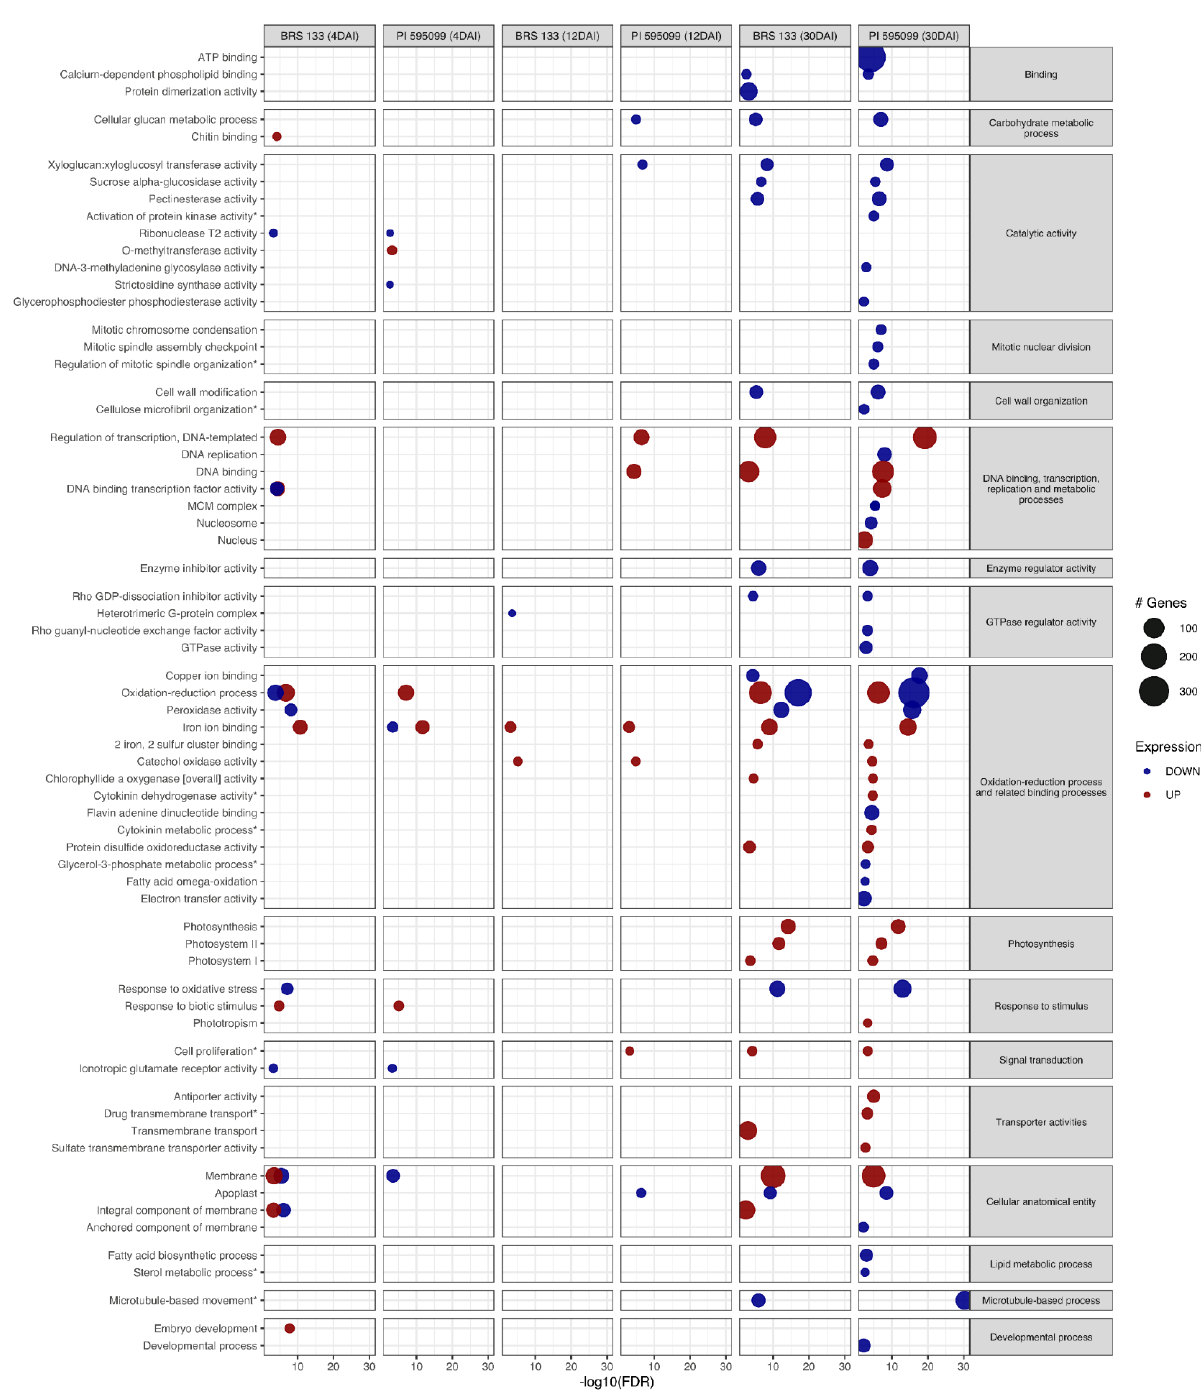
Figure 2. Enrichment of Gene Ontology (GO) terms in the transcriptome of G. max infected with M. incognita . The susceptible BRS 133 and the tolerant PI 595099 genotypes are represented at the top of the bubble chart, followed by the number of days after the infection (DAI) with M. incognita . The GO terms are listed on the left (y-axis). Only GOs with statistical significance (false discovery rate, FDR > 0.05) are included.